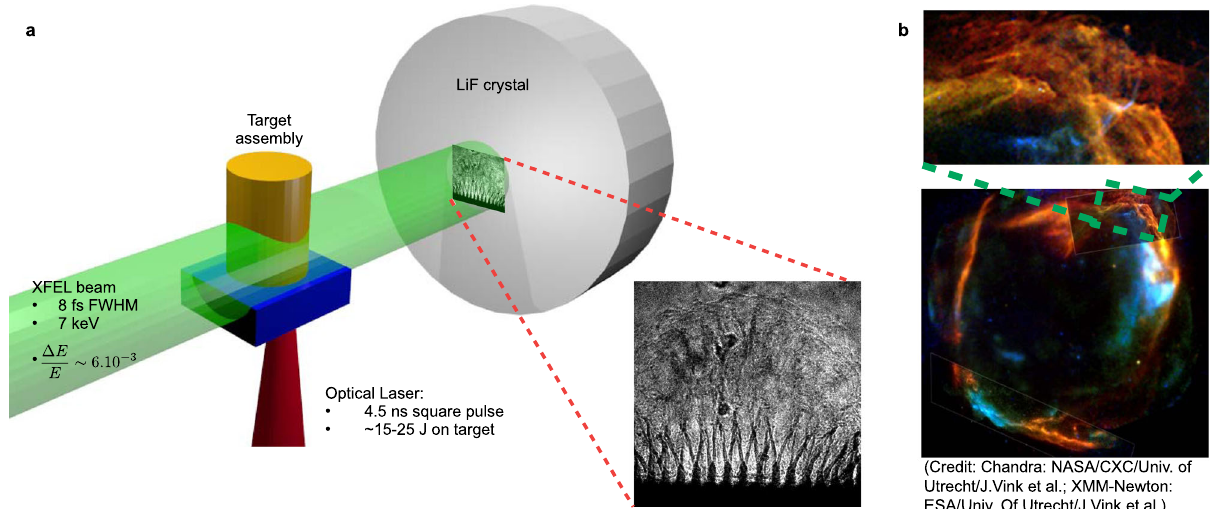
Fig. 1 Experimental setup. Diagram of the overall experiment setup ( a ) and Chandra ’ s observation of RCW 86 ( b ). The plasma expansion inside the laser- driven target is diagnosed using a XFEL beam (>1 mm diameter, 8 fs, centred on a 7 keV emission with a Δ E / E = 6 × 10 − 3 ) and lithium fl uorine crystal. This expansion is Rayleigh – Taylor unstable, as in the supernovae